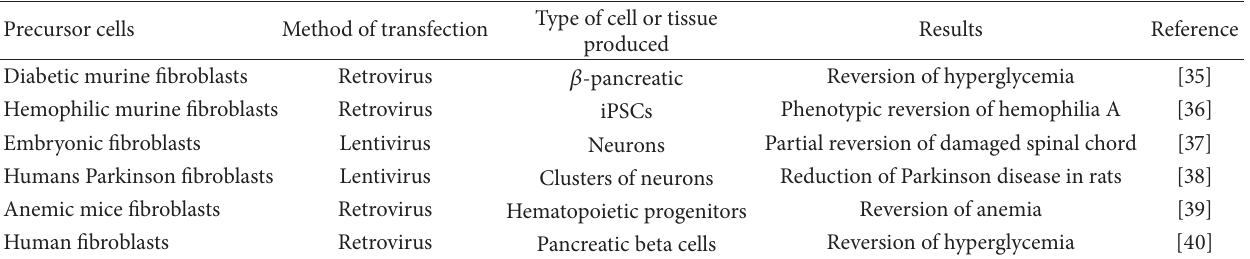
Table 3: Therapeutic use of iPSCs in